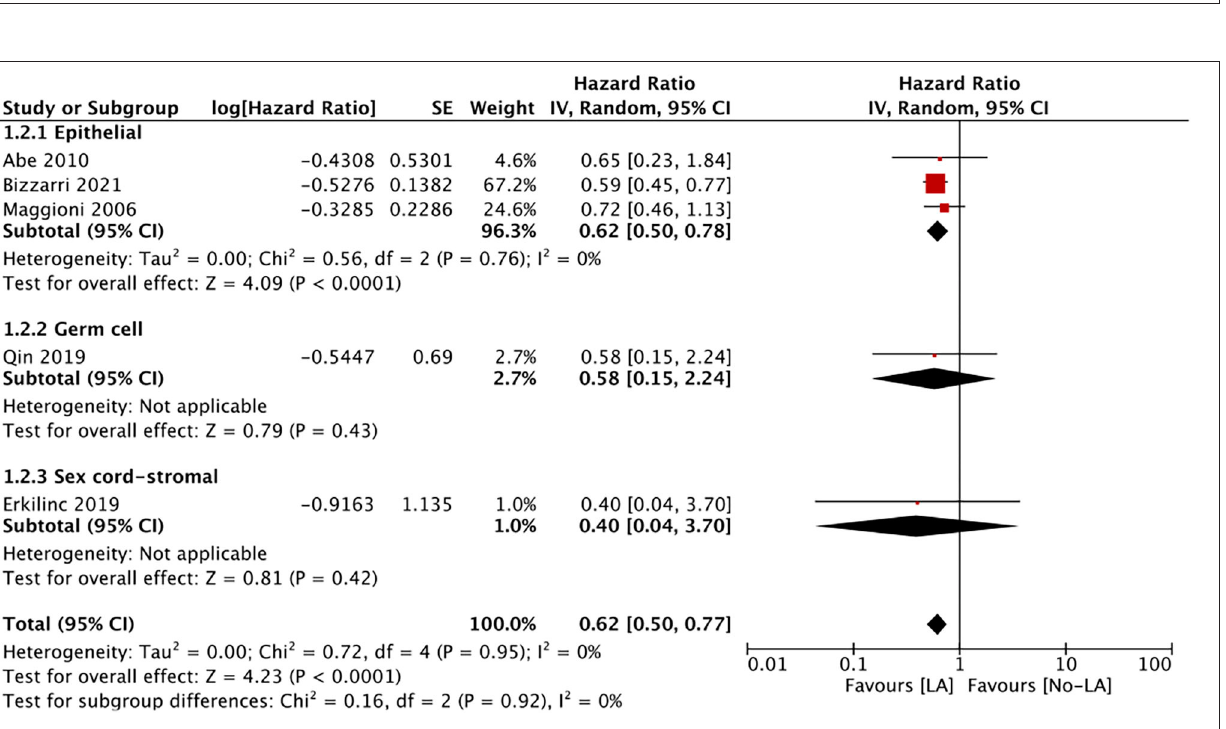
FIGURE 4 | Meta-analysis of DFS for ESOC between lymphadenectomy and control groups with sub-group analysis based on type of ESOC.